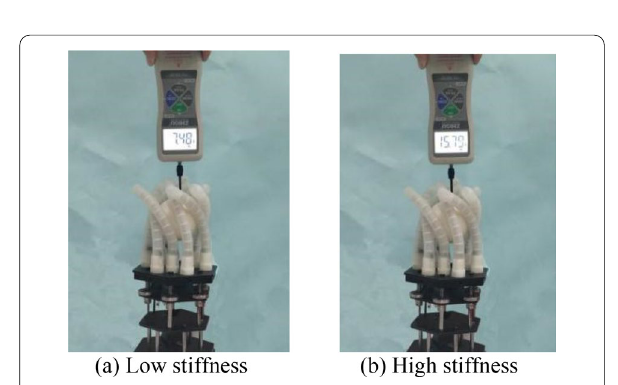
Figure 12 Dynamic capture of a cylinder